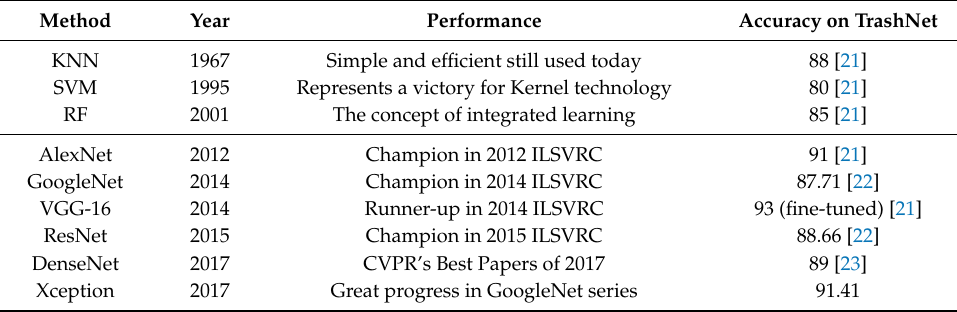
Table 1. Comparison of related